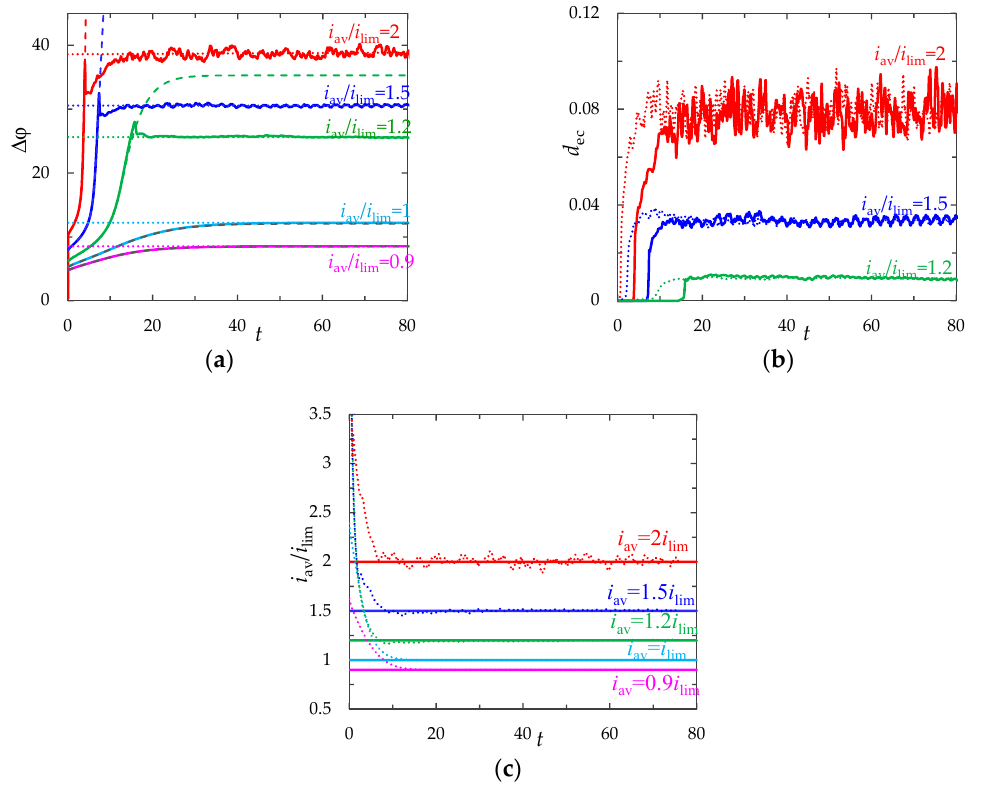
Figure 6. ( a ) ChP calculated with (solid lines) and without (dashed line) taking into account electroconvection; ( b ) the dynamics of the average thickness of the electroconvective mixing layer, d ec ; ( c ) dependence of the average current density on time. The results of calculations in the galvanostatic (solid and dashed lines) and potentiostatic (dotted lines) modes at i av / i lim = 0.9, 1, 1.2, 1.5, 2.